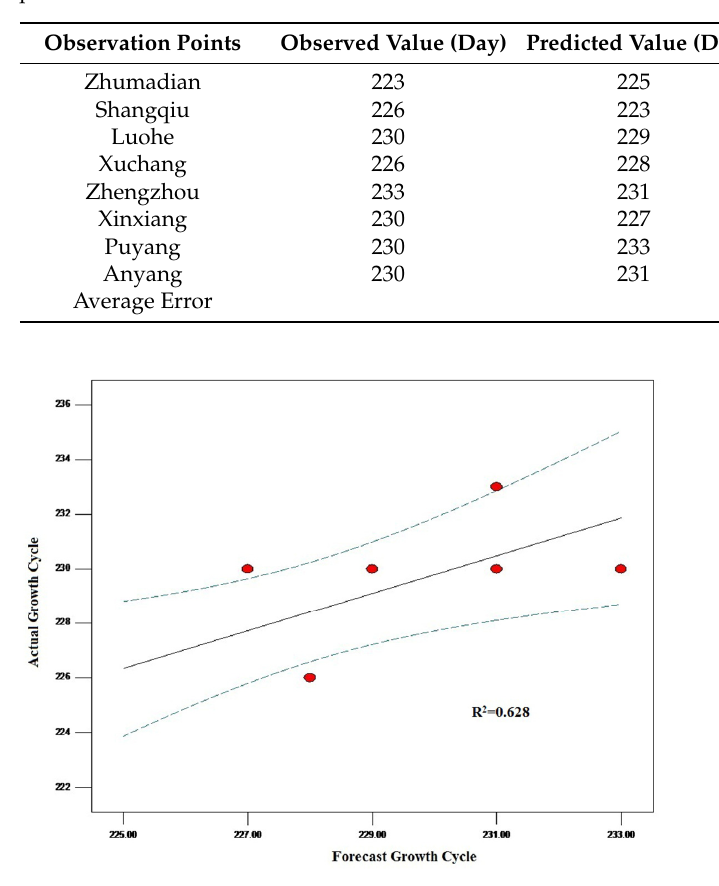
Figure 8. Scatter plot of forecasting the period of harvesting winter wheat in main producing areas of Henan province in